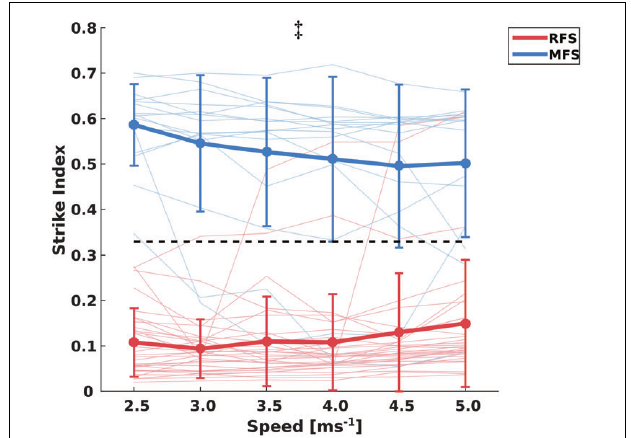
FIGURE 1 | Mean ± standard deviation of the strike indexes throughout the examined speeds and the individual values for both rearfoot strikers (RFS) and mid-forefoot strikers (MFS). The black dotted line indicates the separation between RFS (below 0.33 of strike index) and MFS (above 0.33 of strike index). ‡ : statistically significant group × speed interaction ( p < 0.05) indicating a decrease of strike index only in MFS group.